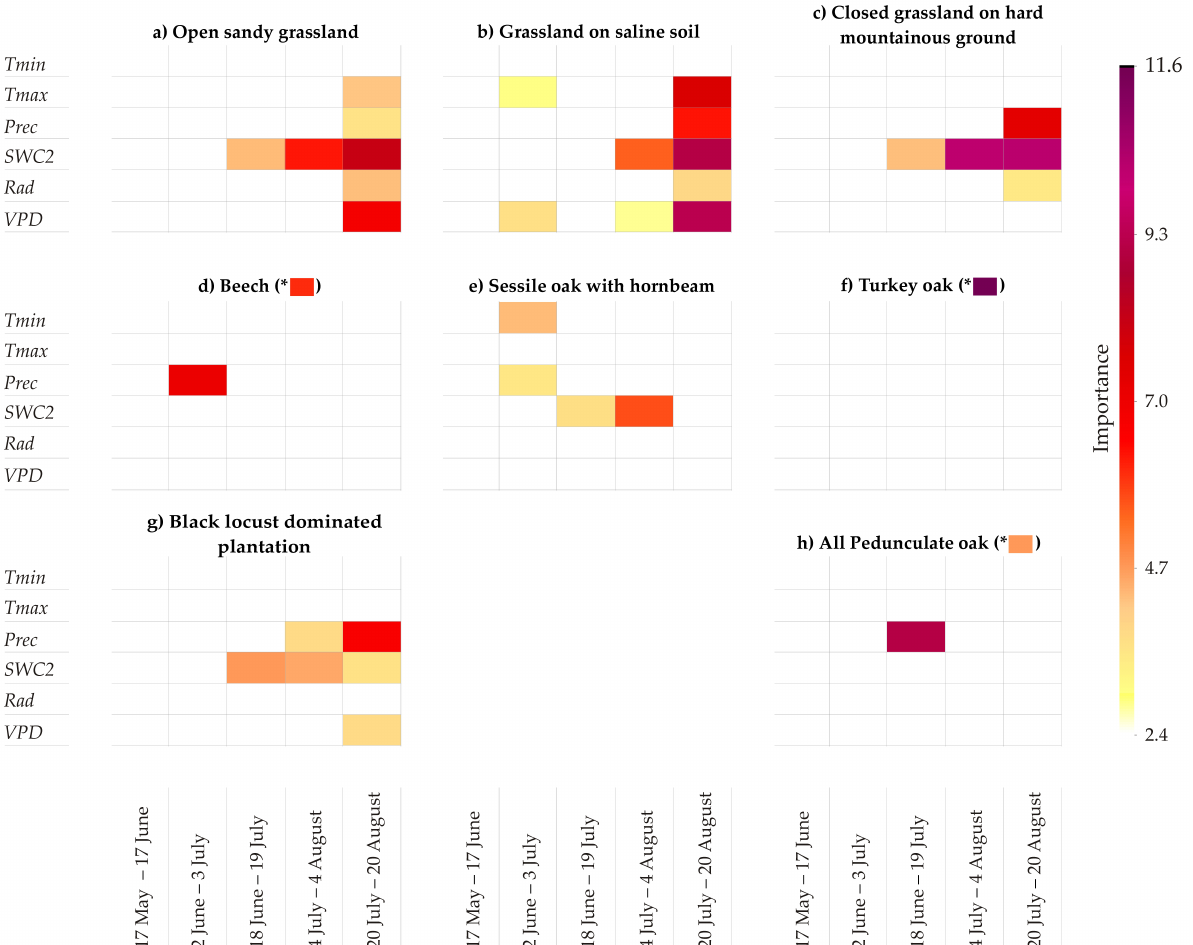
Figure 8. Relevant climate variables affecting the vegetation state (described by NDVI) during the 13 August–13 September period based on the results of the Boruta method. The colors express the “importance” value as the result of the Boruta feature selection. The * and the following colored rectangles indicate that in the case of the given ecosystem category, the Year variable was also found to be relevant, indicating the existence of a